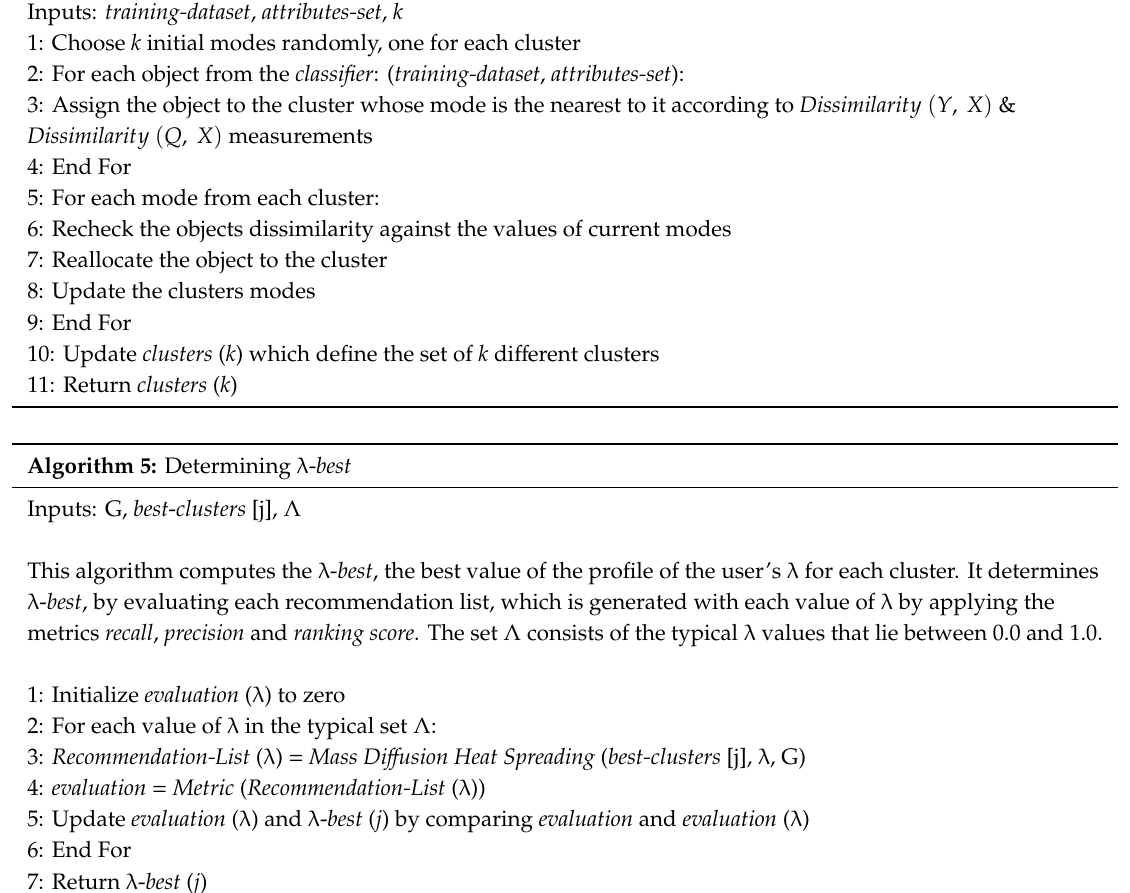
Algorithm 4: k -modes clustering